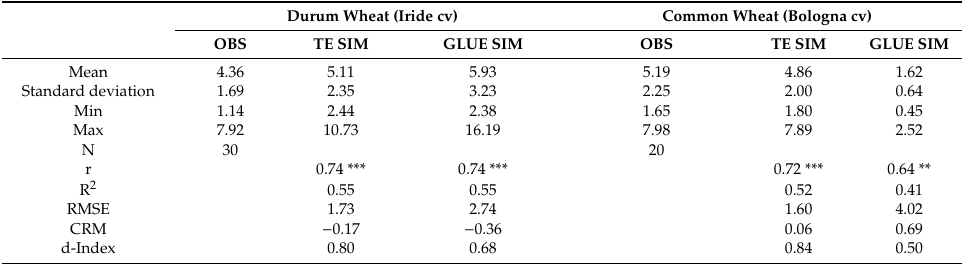
Table 12. Statistical results of observed (OBS) and simulated (SIM) values of grain yield (t ha − 1 ) for durumwheat(Iridecv)andcommonwheat(Bolognacv)fortheevaluationofCSM-CERES-Wheatmodel.